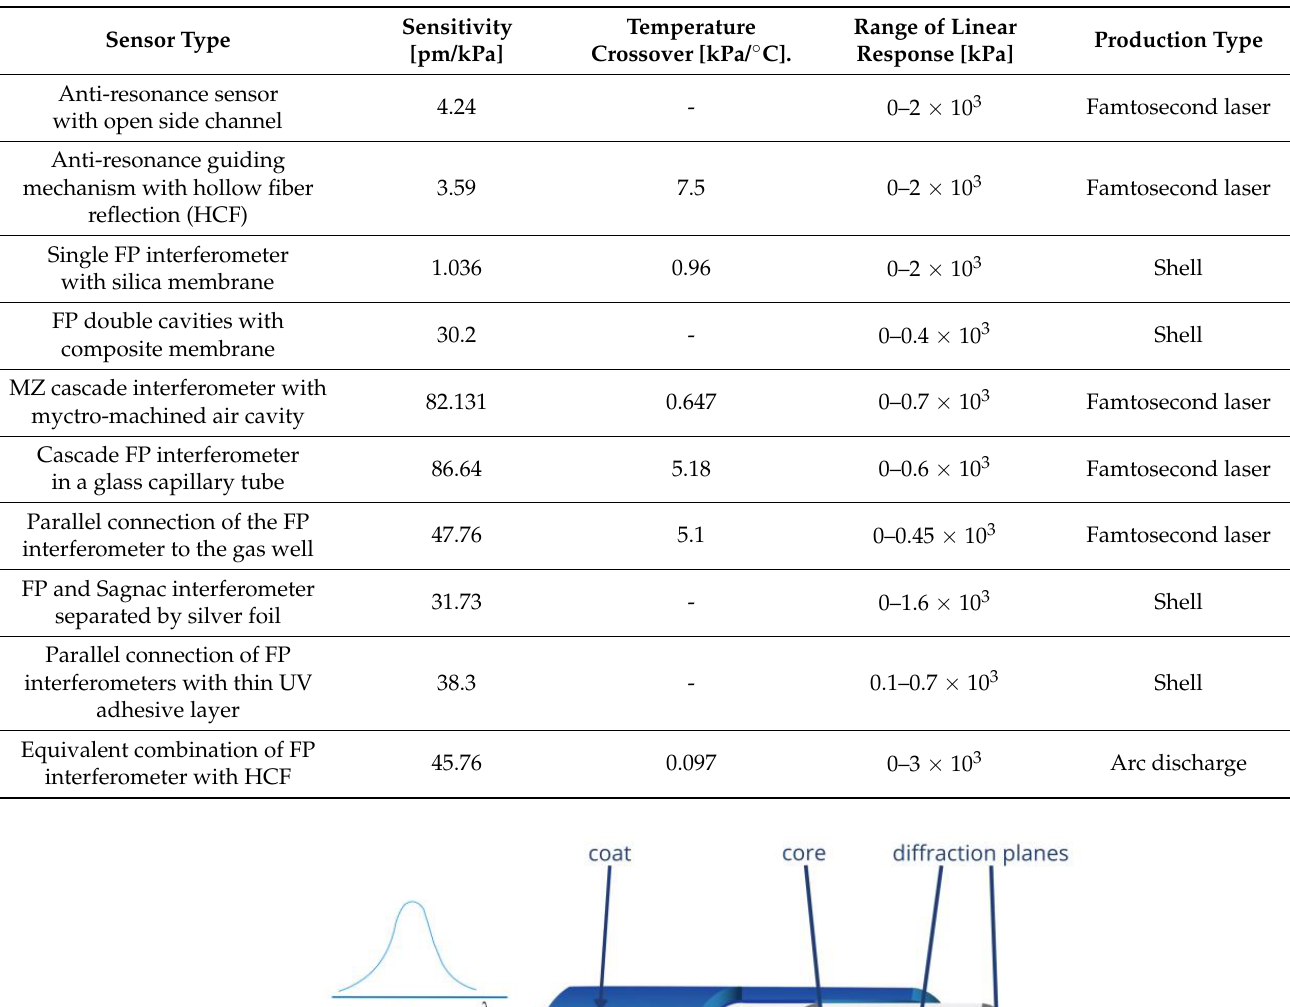
Table 5. Overview of different fiber optic gas pressure sensors [61,83,86–103].